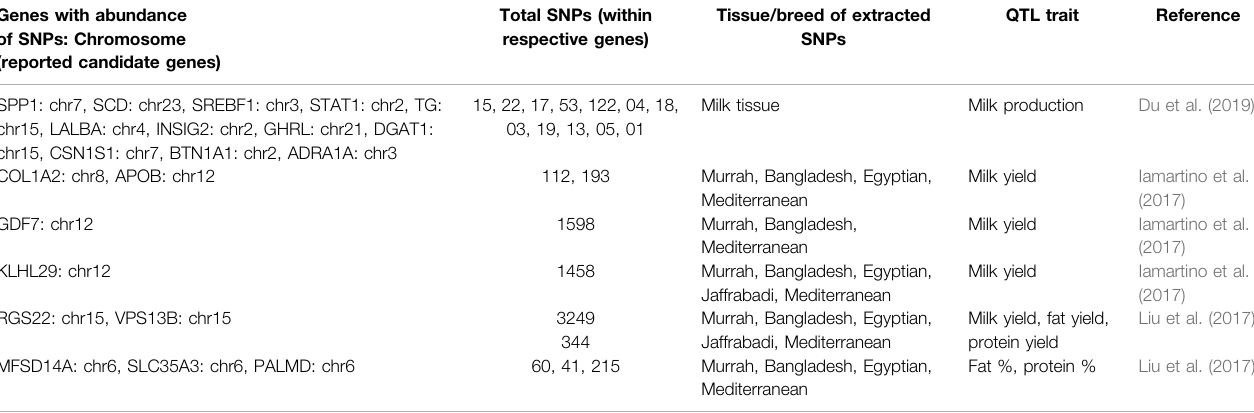
TABLE 4 | Genes with abundance of extracted tissue/breed SNPs found to be common within the reported candidate genes of QTL traits. Genes with abundance of SNPs: